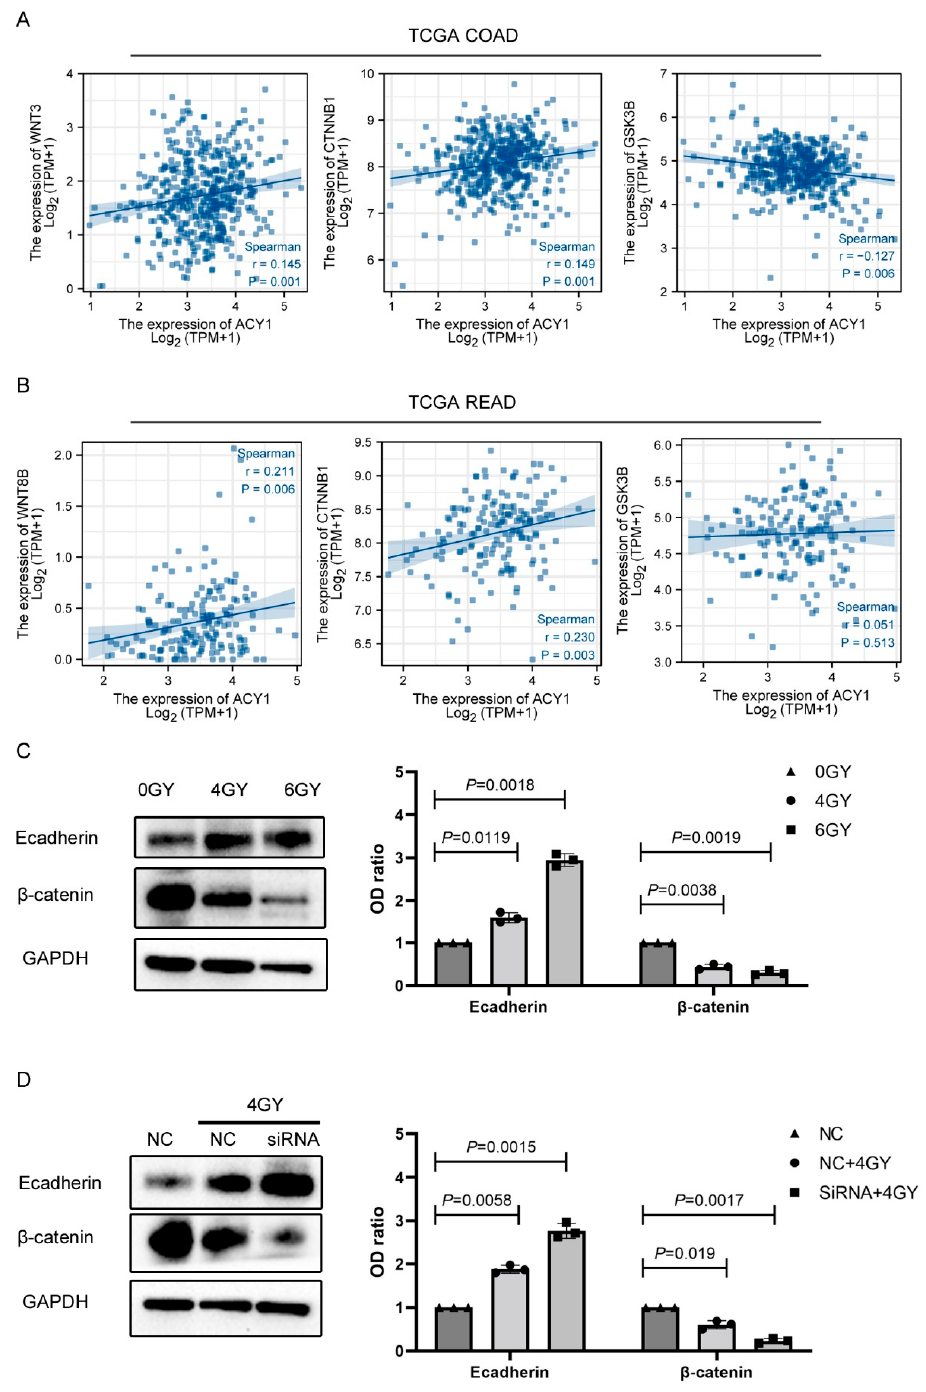
Figure 7. ACY1 inactivated the Wnt/ β -catenin pathway to regulate the radiosensitivity of HCT116-R cells. ( A ) Spearman’s correlation analysis of ACY1 expression and WNT3, CTNNB1, and GSK3B in the TCGA COAD dataset. ( B ) Spearman’s correlation analysis of ACY1 expression and WNT8B, CTNNB1, and GSK3B in the TCGA READ dataset. ( C ) The Western blot assay revealed the expression of E-cadherin and β -catenin in HCT116-R cells treated with 0, 4, and 6 Gy. ( D ) The Western blot assay revealed that the levels of E-cadherin and β -catenin in HCT116-R cells transfected with siRNA-NC or siRNA-ACY1 treated with 4 Gy. The experiment was repeated three times, and the data are presented as the mean ±